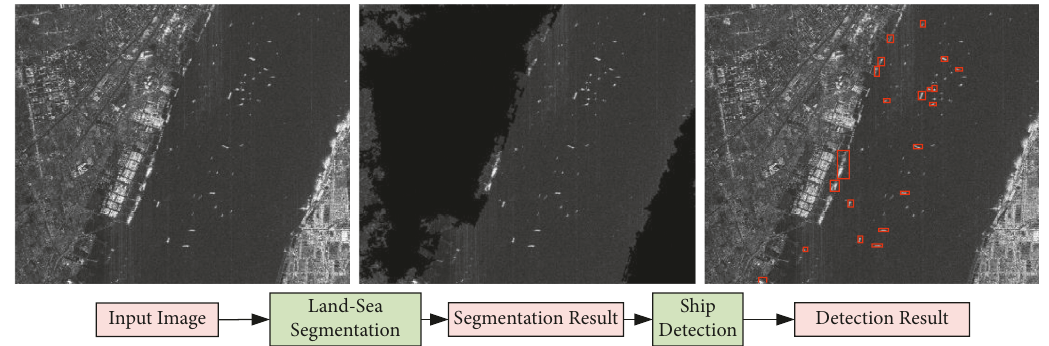
Figure 1: The flowchart of the usual ship detection